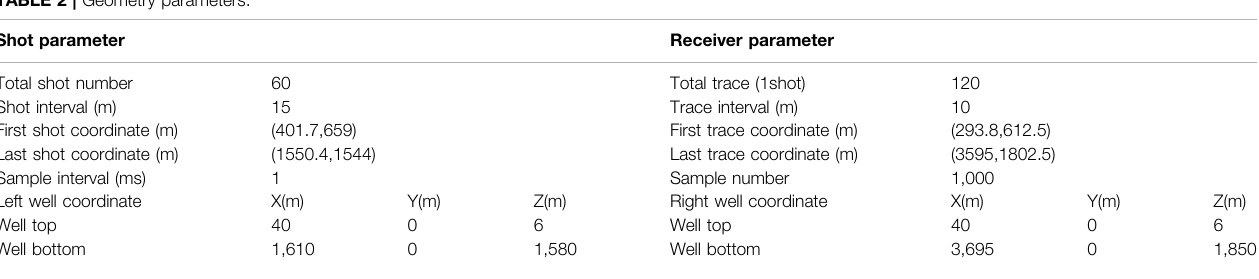
TABLE 2 | Geometry